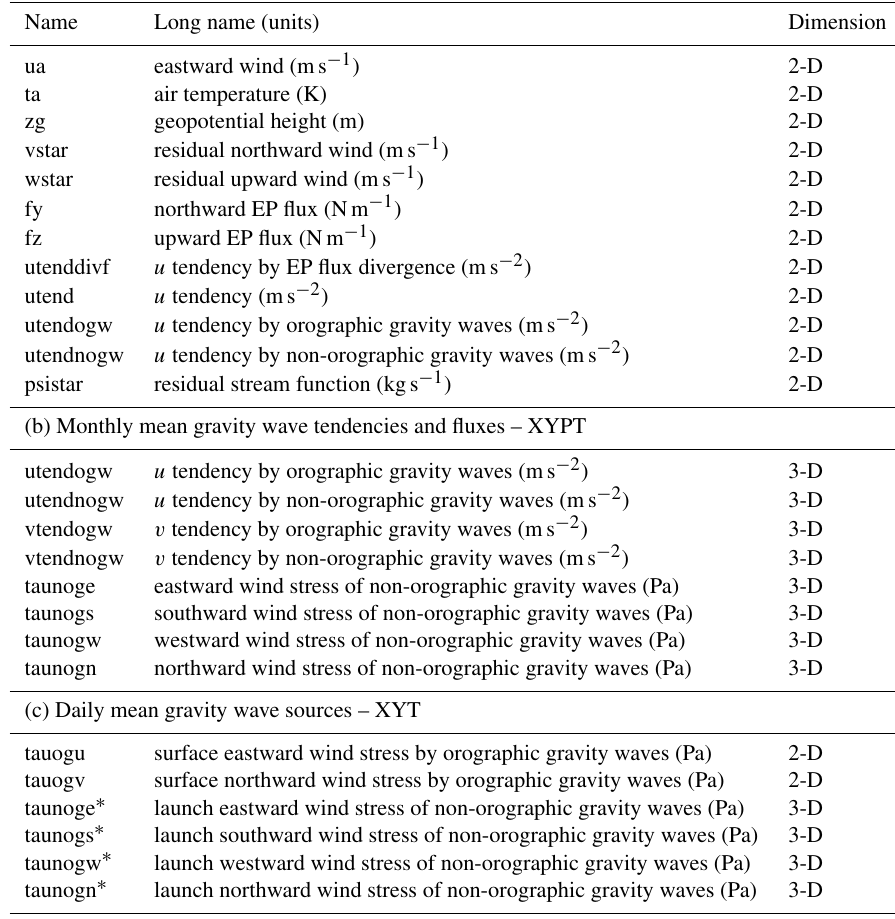
Table 2. Dynamics. ( a ) Monthly mean and daily mean fields and contributions to zonal-mean zonal momentum equation (YPT). ( b ) Monthly mean tendencies and fluxes from parameterized gravity waves (XYPT). ( c ) Daily mean sources for orographic and non-orographic gravity waves (XYT). P is the standard 30-level set of diagnostic pressure levels described in Sect. 4.1 (also Table 1 caption).